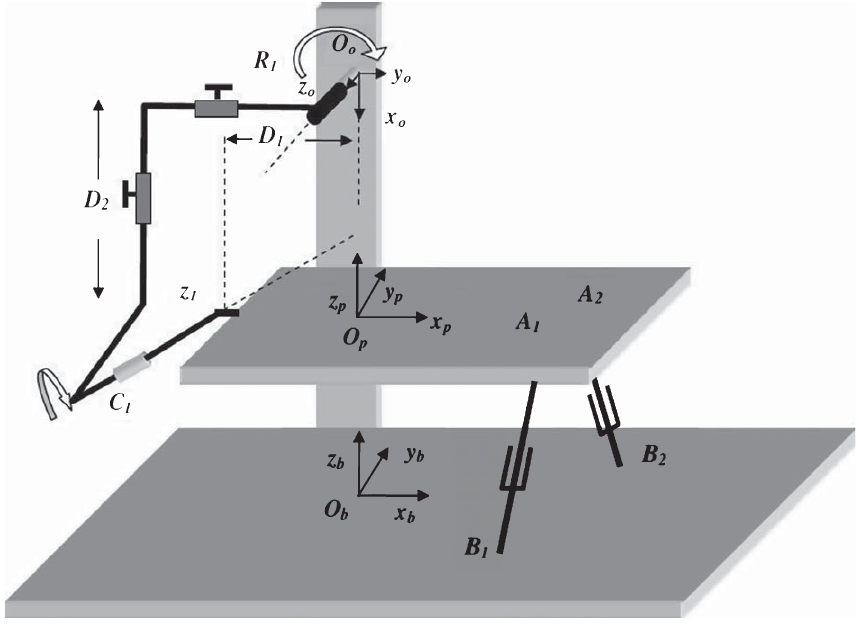
Fig. 7. The 2-DOF hybrid parallel-serial robotic platform for ankle